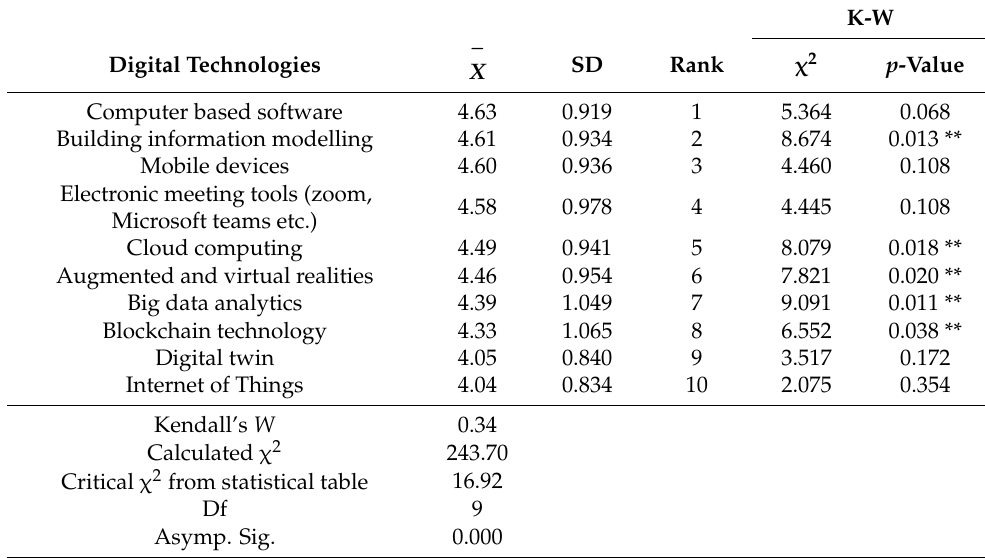
Table 1. Digital technologies that can affect the VM process.